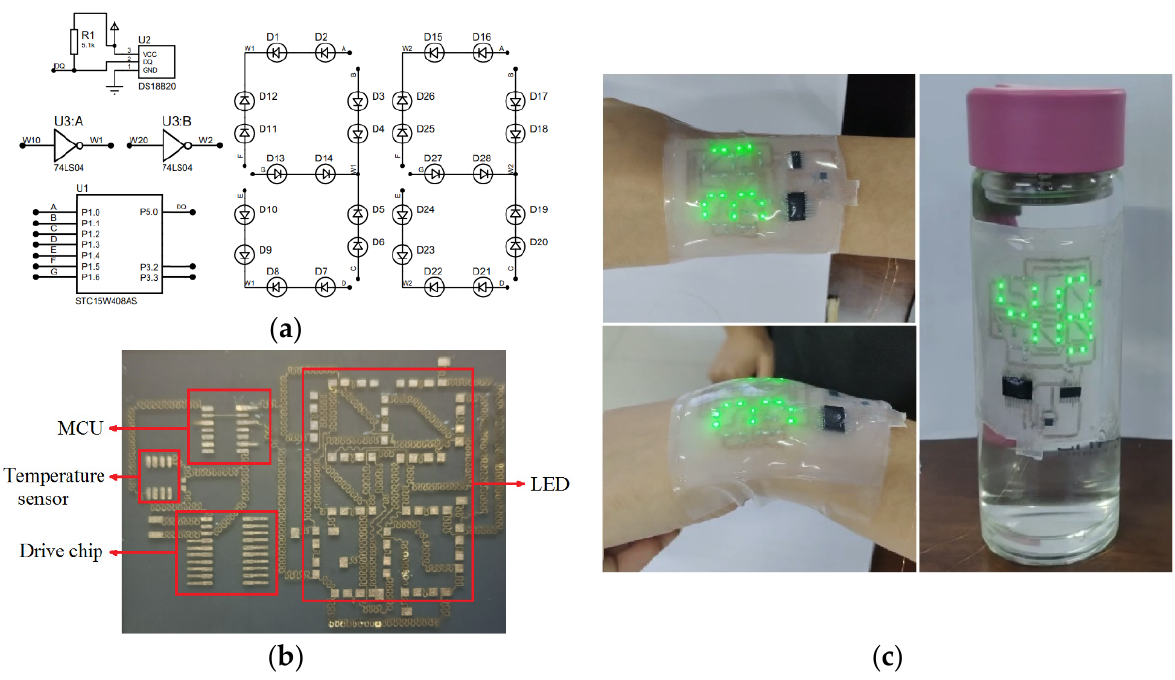
Figure 12. Stretchable temperature measuring circuit. ( a ) Schematic diagram of temperature measuring circuit; ( b ) electrode diagram of temperature measuring circuit; ( c ) application test of temperature measuring circuit.